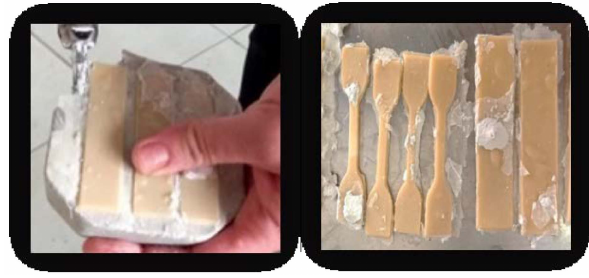
Figure 3. Divesting resin samples.